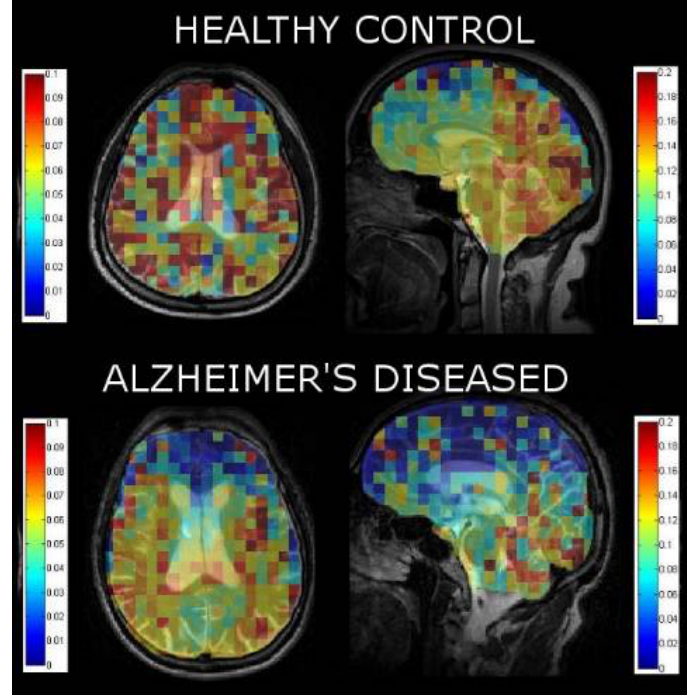
Figure 5. Xenon washout parameter maps of healthy controls age-matched to AD patients overlaid on T2W anatomical images.